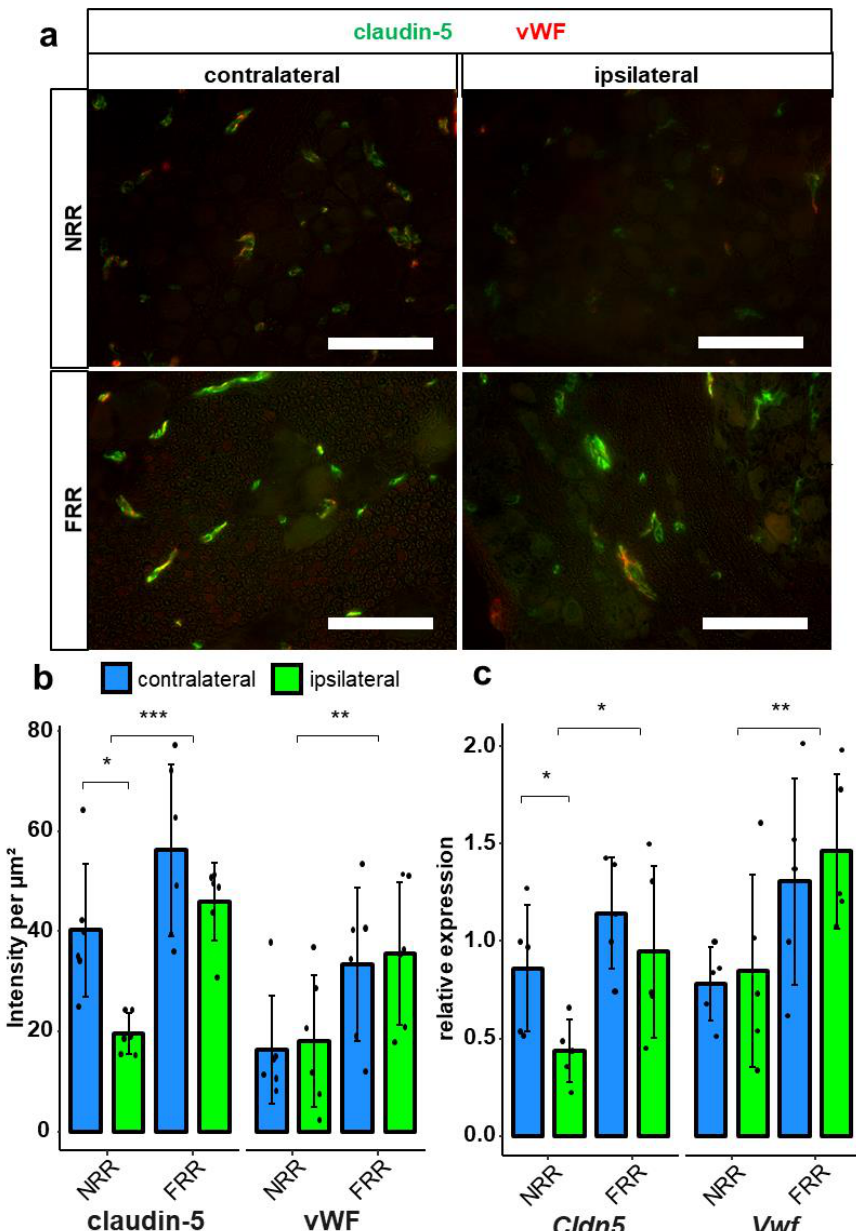
Figure 6. Claudin-5 IR within vessels and Cldn5 mRNA in the NRR are reduced in rat DRGs. DRG sections from Wistar rats after CCI were immunostained. Quantification of claudin-5 and van Willebrand factor (vWF) IRs and comparison between IL and CL DRGs after CCI in the NRR and FRR as light intensity per µm². Tissue samples from the NRR and vessels of the FRR were obtained using laser microdissection (LMD). Claudin-5 and vWF mRNA were quantified as relative expression (to GAPDH) via RT-qPCR. Representative sections of co-stainings with claudin-5 (green) and vWF (red) ( a ). Quantification of the claudin-5 and vWF IR ( b ) n = 6; claudin-5: FRR versus NRR, p = 0.000261; NRR: CL versus CCI, p = 0.02985; vWF: NRR versus FRR, p = 0.00515. No normal distribution: claudin-5 FRR CCI, vWF NRR CL. No variance homogeneity: claudin-5 FRR. Two-way ANOVA, Tukey HSD.) And quantification of mRNA expression ( c ) n = 5; Cldn5 : NRR versus FRR, p = 0.0136; CL versus IL: p = 0.0448; Vwf : NRR versus FRR, p = 0.00838; two-way ANOVA, Tukey HSD) in the specified areas. (Scale bars = 100 µ m. * p < 0.05, ** p < 0.01, *** p < 0.001.) All results are summarized in Table